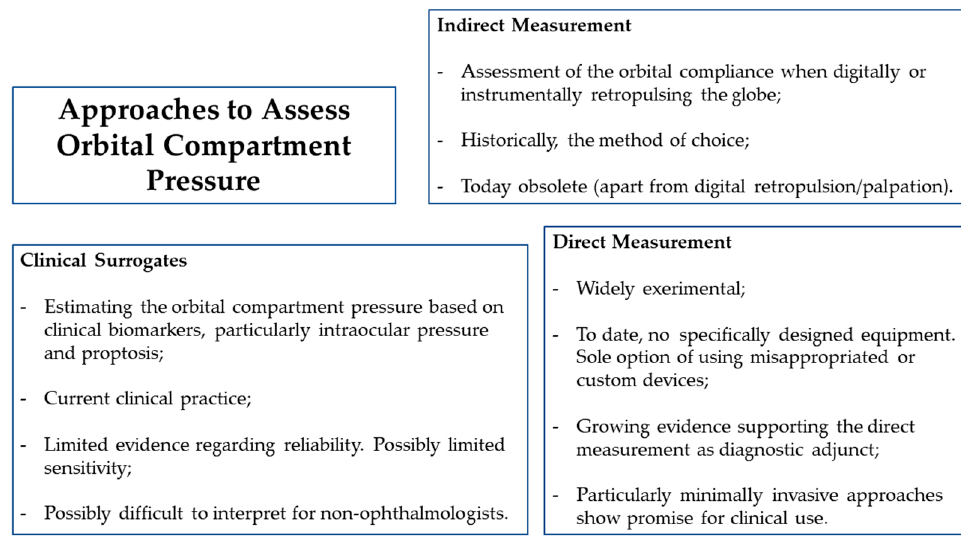
Figure 3. Overview of the different approaches to assess orbital compartment pressure and the corresponding main conclusions.